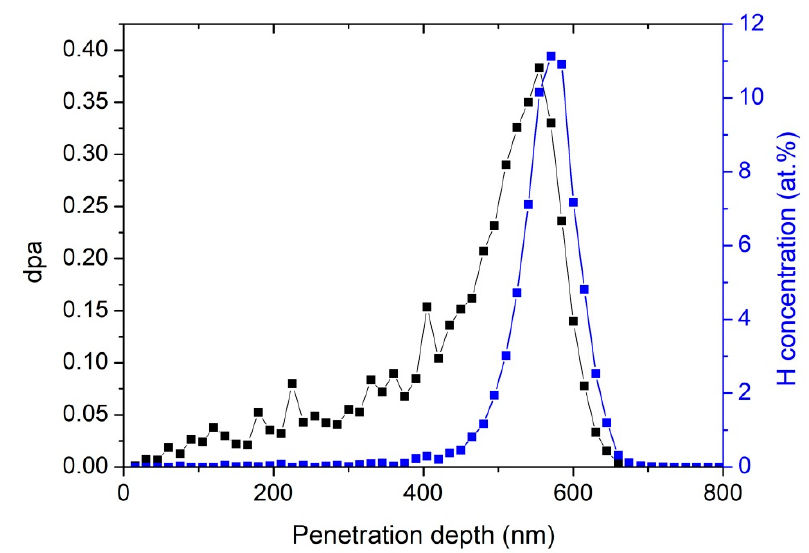
Figure 1. Depth distributions of the displacements per atom (dpa) and the projected range of 194 keV H 2+ -implanted 6H-SiC to a fluence of 5 × 10 16 H 2+ /cm 2 simulated using the SRIM-2013 code (density of 3.21 g/cm 3 and displacement energies of C = 20 eV and Si = 35 eV).